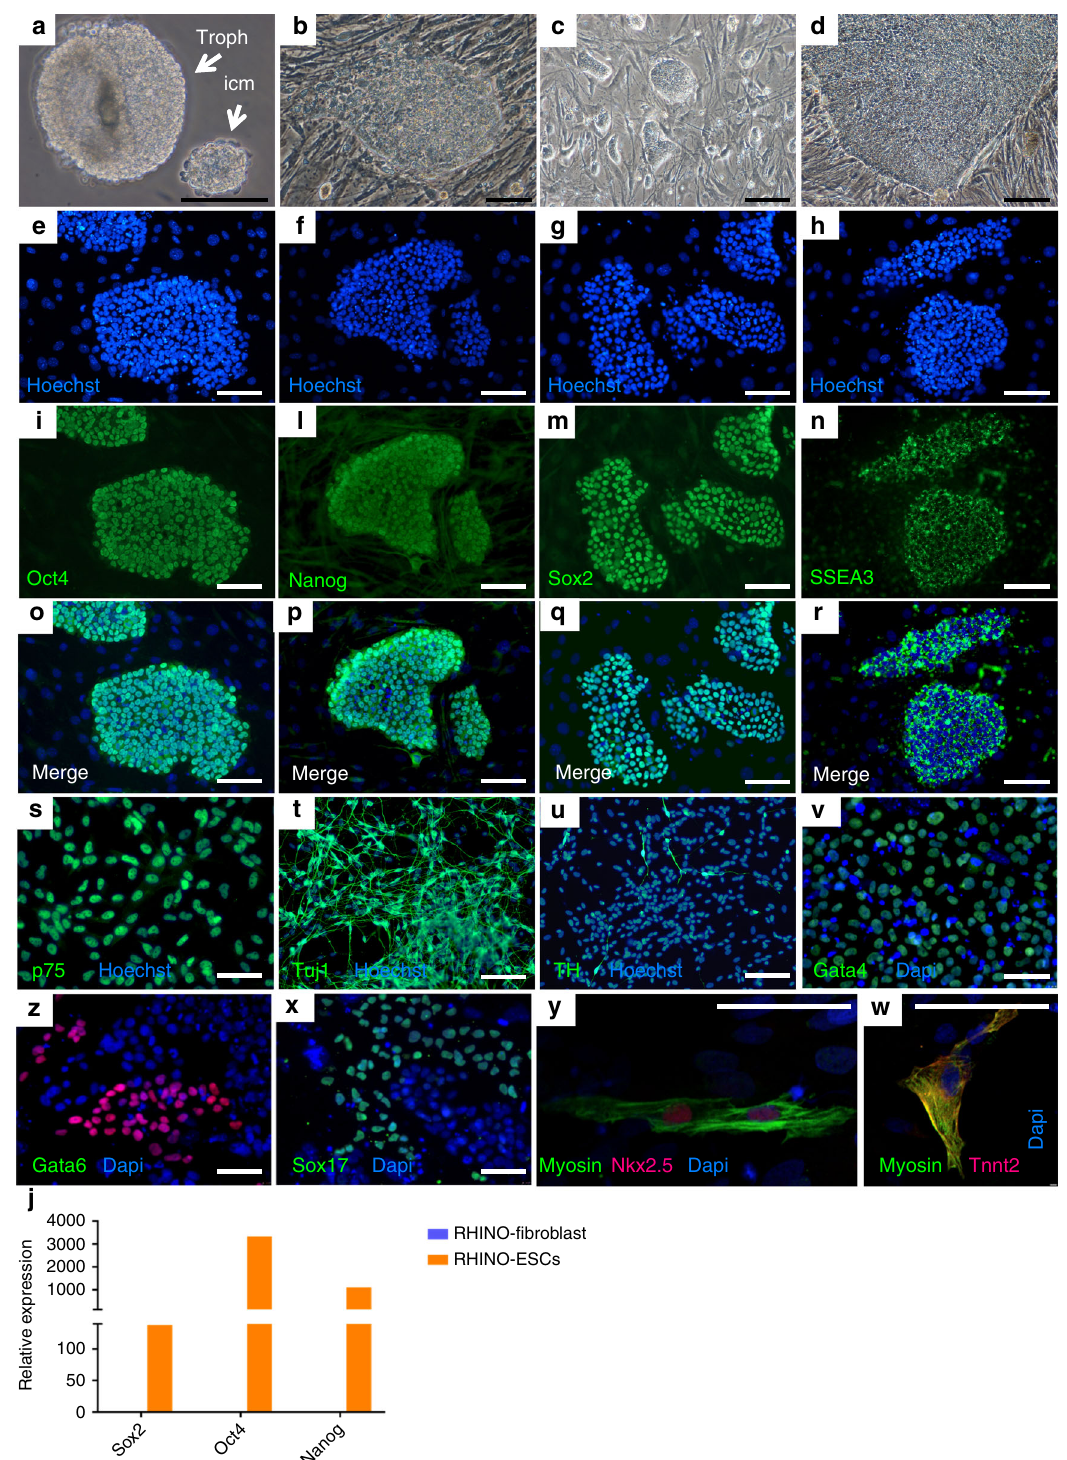
Fig. 3 Isolation of inner cell mass and derivation/characterization of embryonic stem cell lines. a Isolated ICM and trophoblast from rhinoceros embryo after mechanical dissection with insulin needles (40×); b ICM outgrowth 48 h after plating on feeder cells (20×). c Representative image of ES colonies 24 h after enzymatic passaging; d ES colonies ready for the next passaging. Characterization of undifferentiated ES colonies: e , i , o OCT4 staining; f , l , p NANOG staining; g , m , q SOX2 staining; h , n , r SSEA3 staining. Characterization of differentiated derivatives: s p75 staining of neural crest precursors; t , u Tuj1 and TH staining of neuronal cells; v , z , x GATA4, GATA6, SOX17 staining of endodermal cells; y , w MYOSIN, NKH2.5, TNNT2 staining of myocardial cells. Bar 100 µ m; j RT-PCR for SOX2, OCT4 , and NANOG in fi broblasts and rESC ( n = 1 sample for each cell